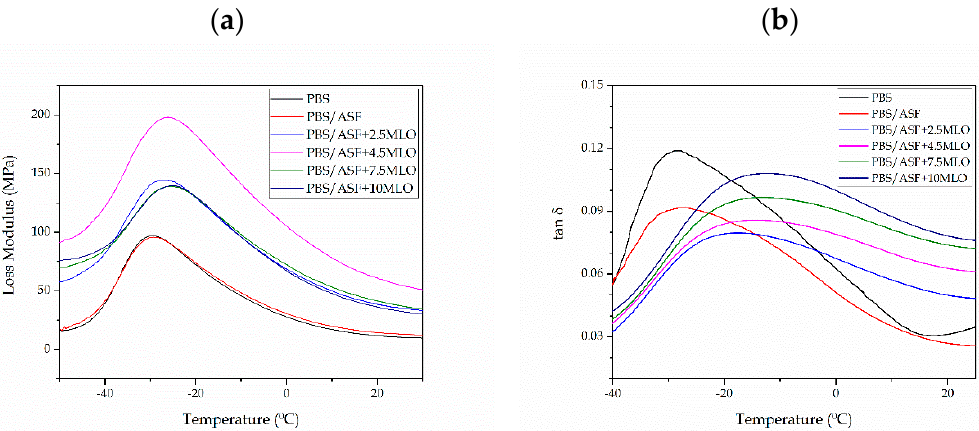
Figure 4. Plot evolution of ( a ) loss modulus (E”) and ( b ) damping factor (tan ∂ ) of neat PBS and PBS/ASF composites with different MLO compatibilizer content.